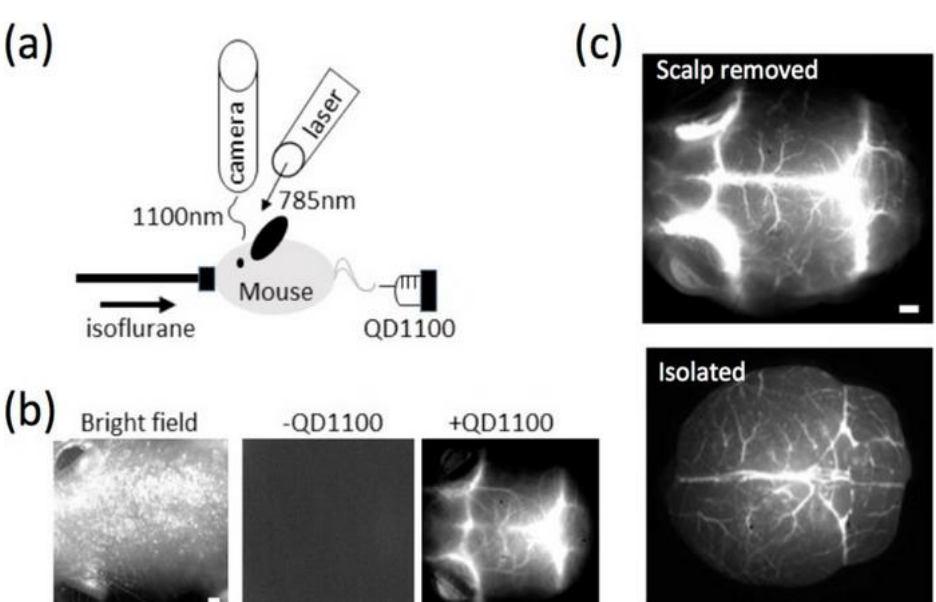
Figure 18. ( a ) Setup for NIR fluorescence imaging of cerebral arteries. ( b ) Imaging of a mouse head. Bright field micrograph ( left ), NIR fluorescence image without ( middle ), and with QDs ( right ). ( c ) NIR fluorescence pictures of cerebral blood vessels. The upper image shows the fluorescence after the scalp has been removed, whereas the lower micrograph shows the fluorescence after separation — with one-millimeter scale bars. Taken from ref. [153], copyright 2016, with permission from MDPI.